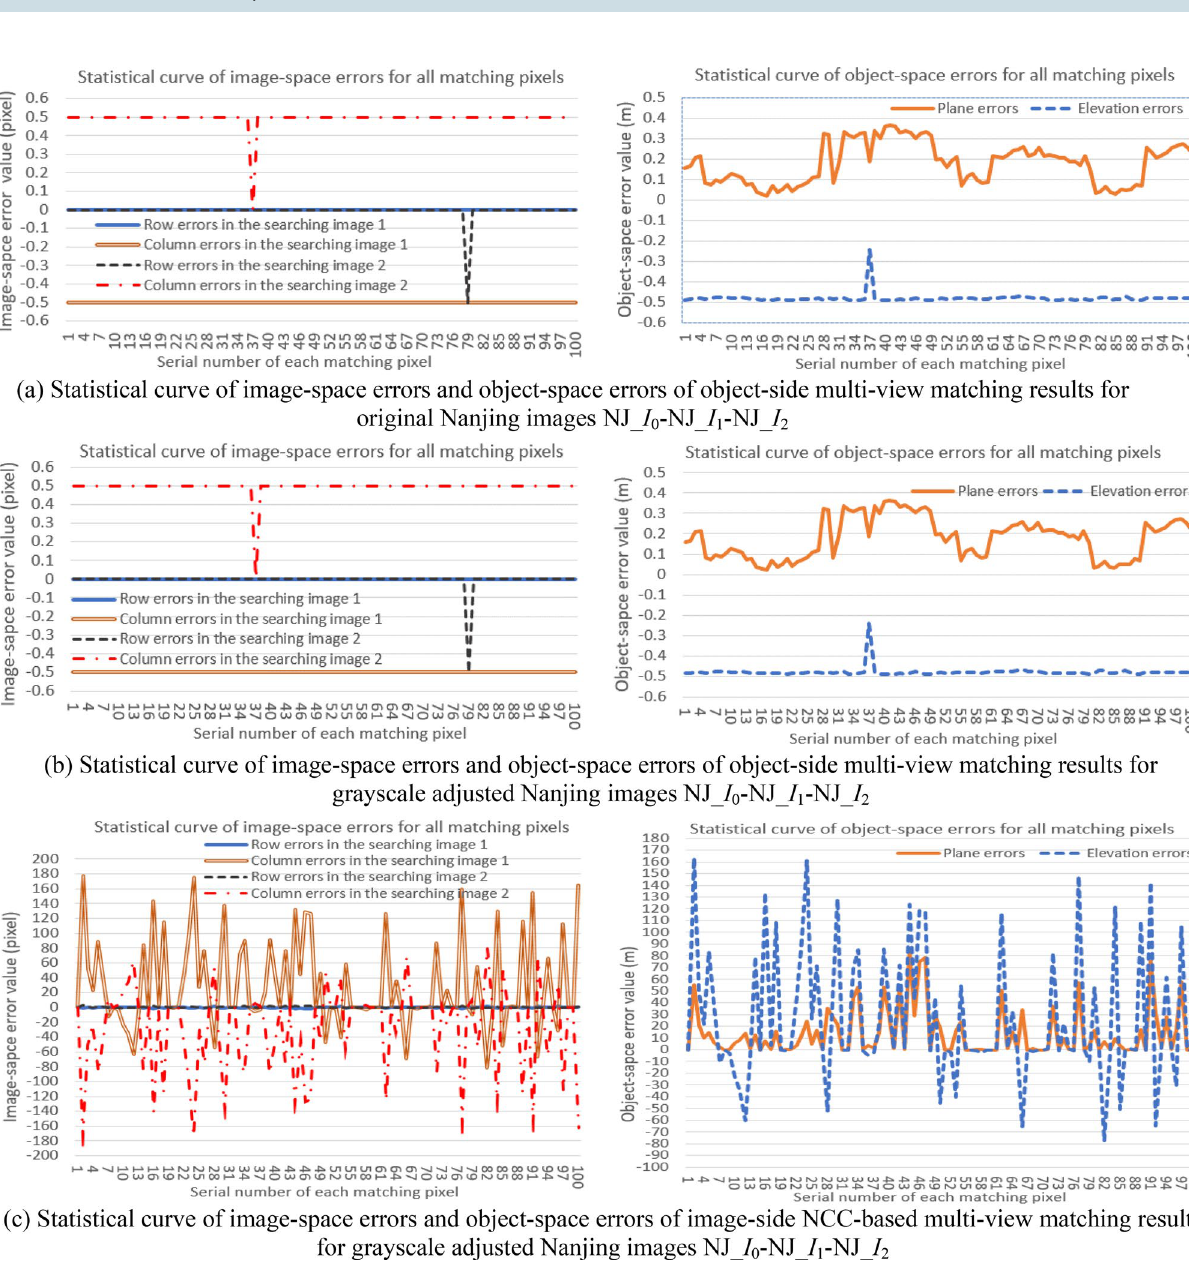
Figure 12. The comparative results of statistical curve of image-space errors (left column) and object-space errors (right column) of different multi-view matching results for original and grayscale adjusted Nanjing images (All these graphs were created by Microsoft Excel